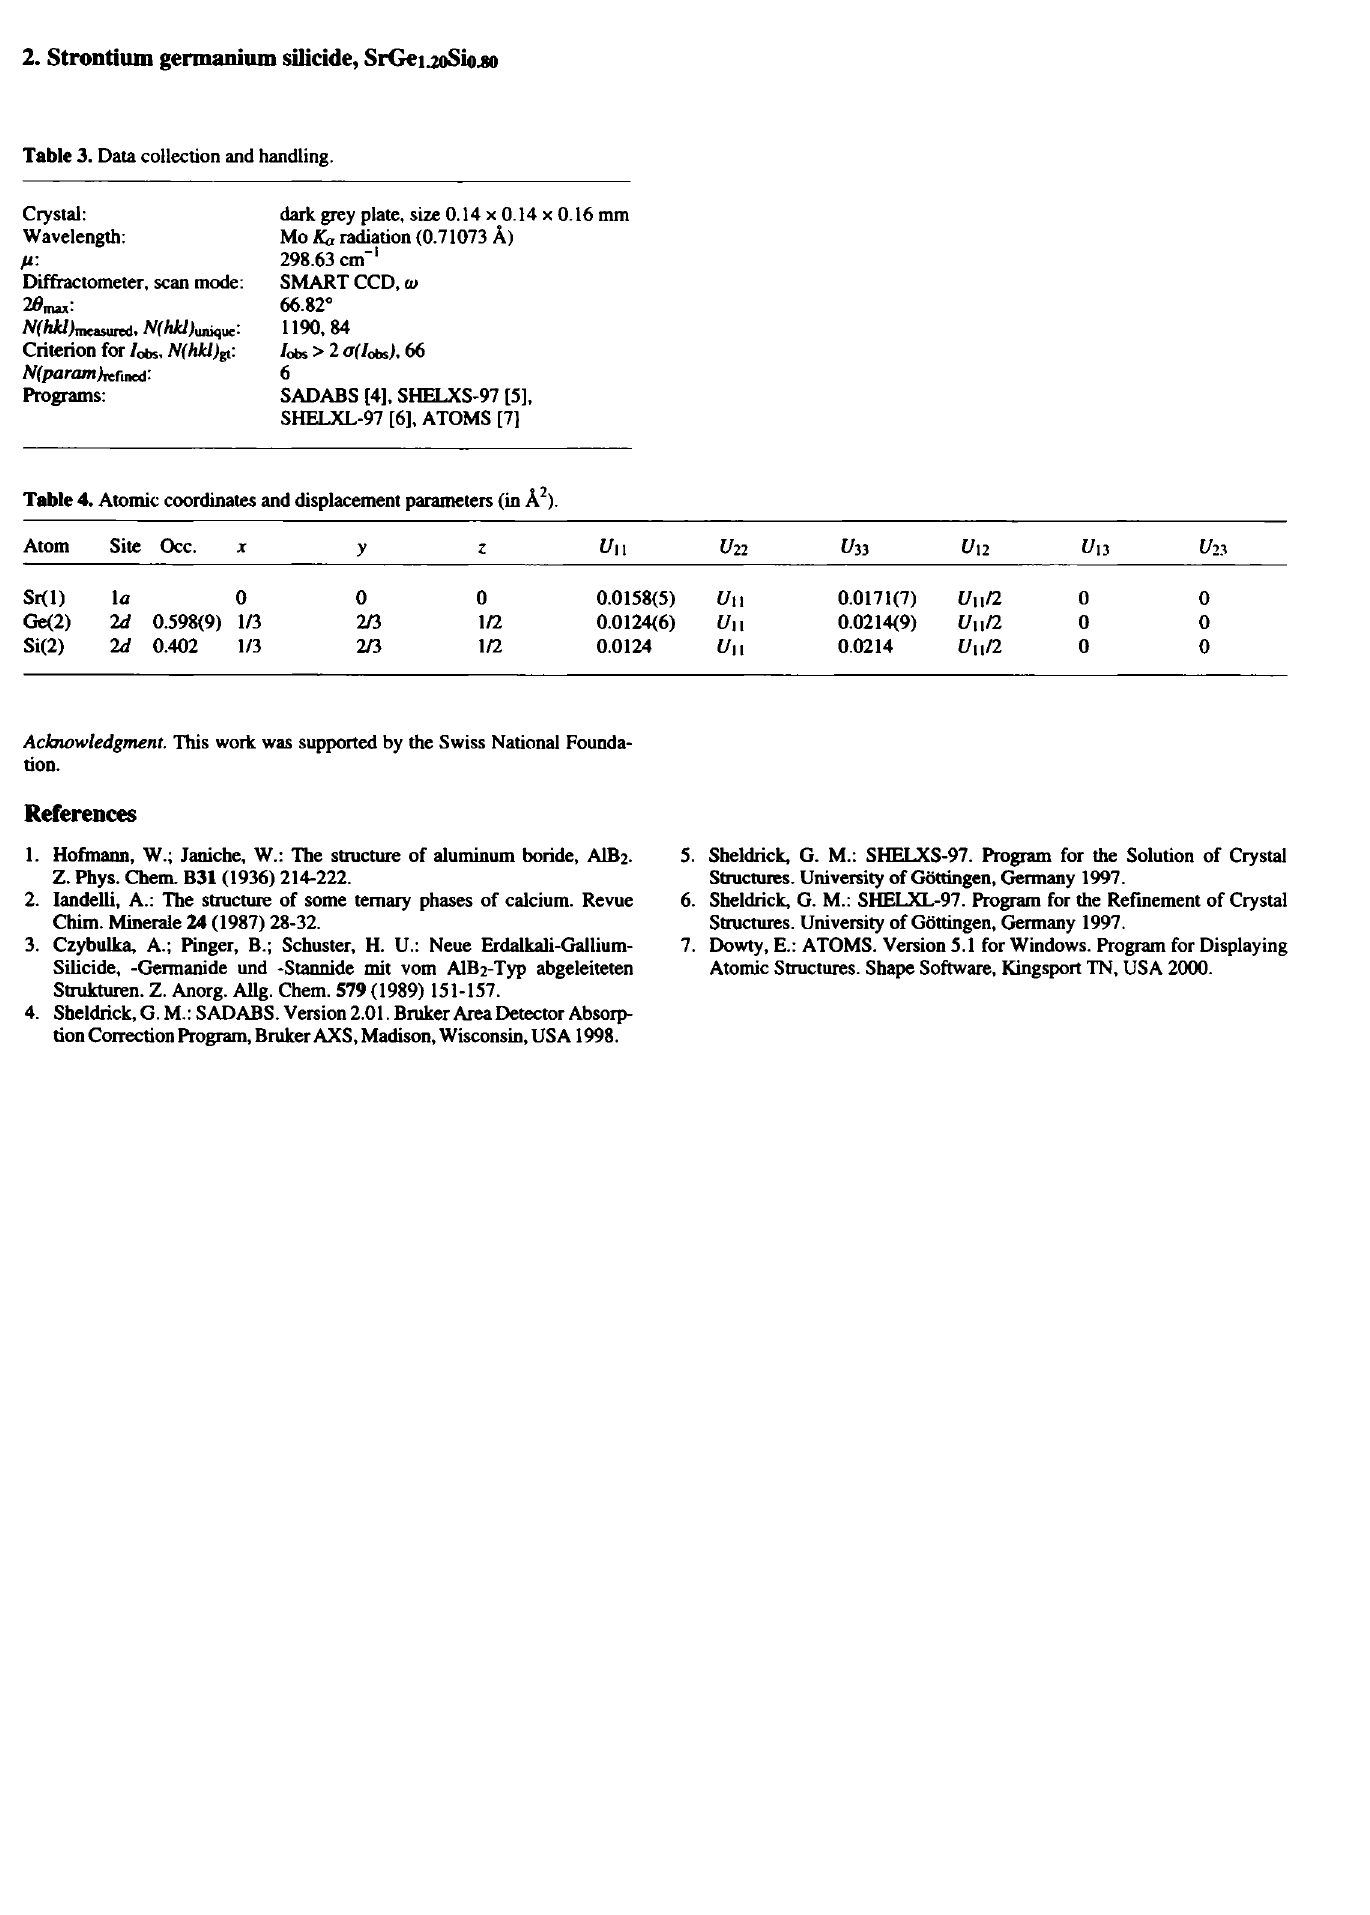
Table 3. Data collection and handling.